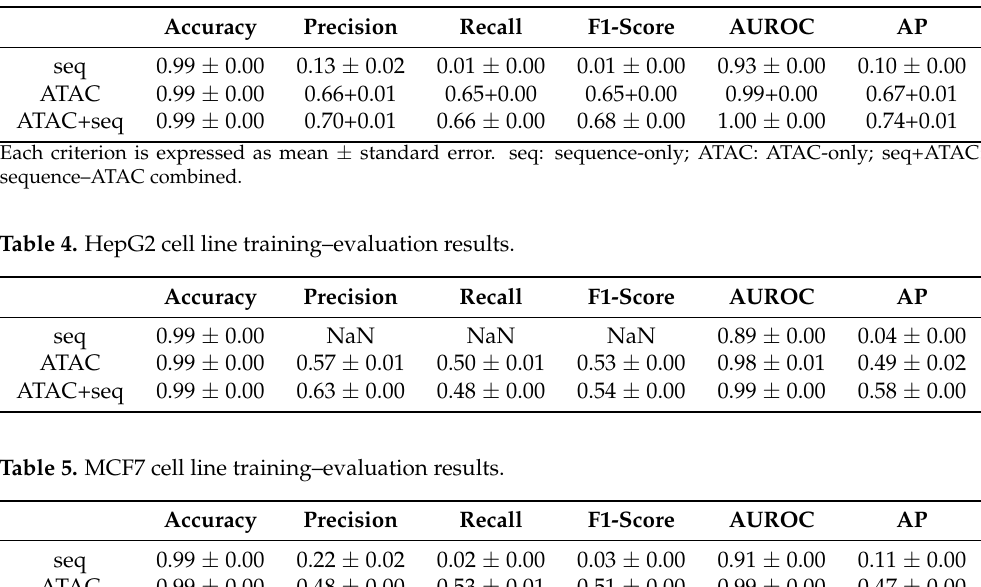
Table 3. K562 cell line training–evaluation results.